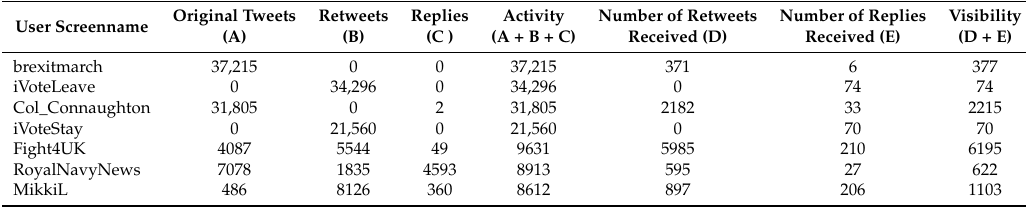
Table 2. Top 25 Active